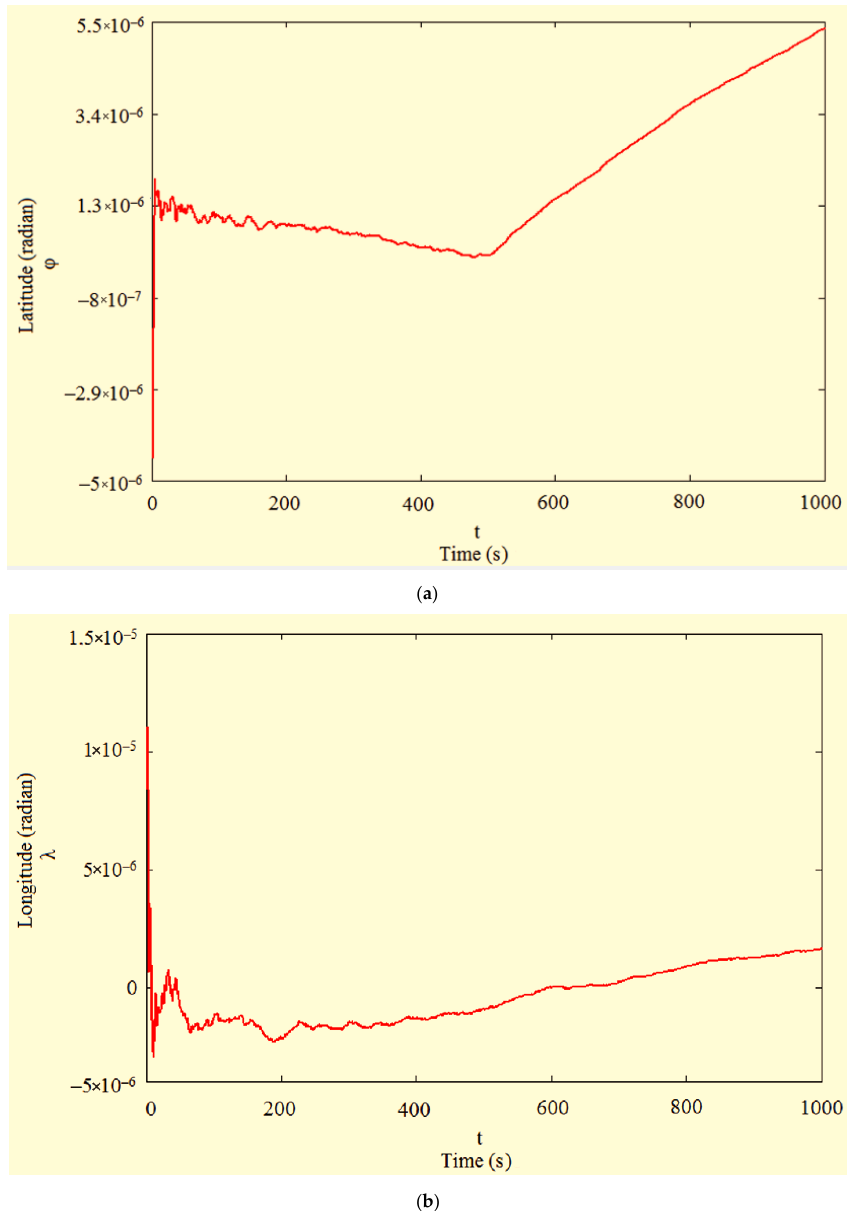
Figure 1. Graphs of latitude φ ( a ) and longitude λ ( b ) estimation errors obtained when implementing the classical Kalman filter. When organizing an adaptive filter in accordance with the above algorithm, the esti- mation errors for the same modeling variant have the form shown in Figure 2.